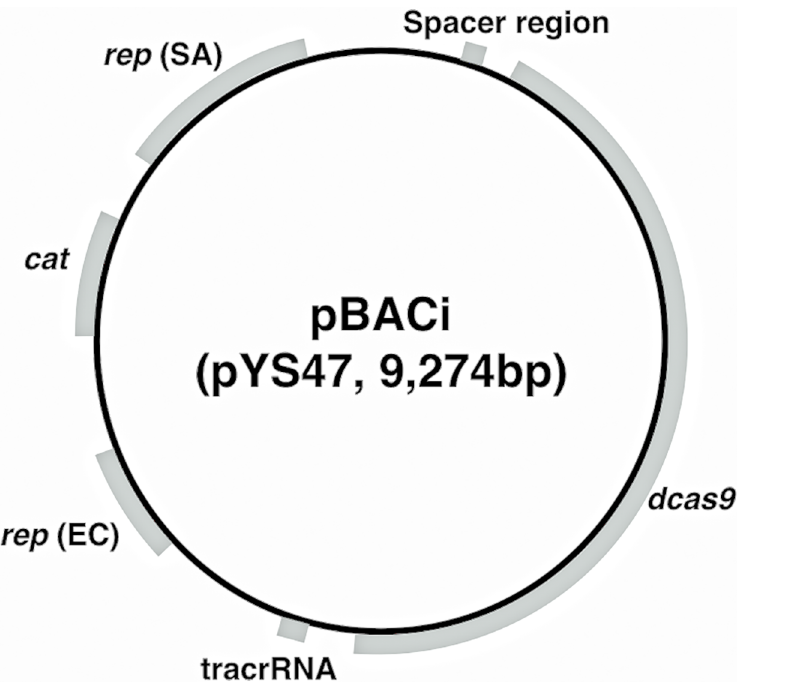
Fig 1. Plasmid map of pBACi, CRISPRi plasmid for S . aureus